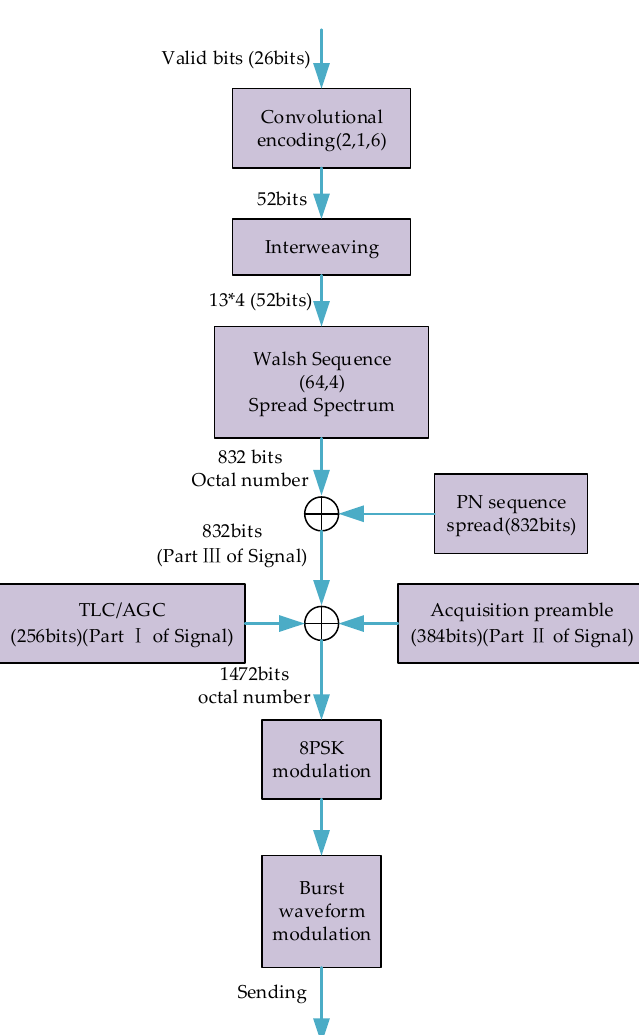
Figure 3. How the LE behavior signals used in experiments are generated.